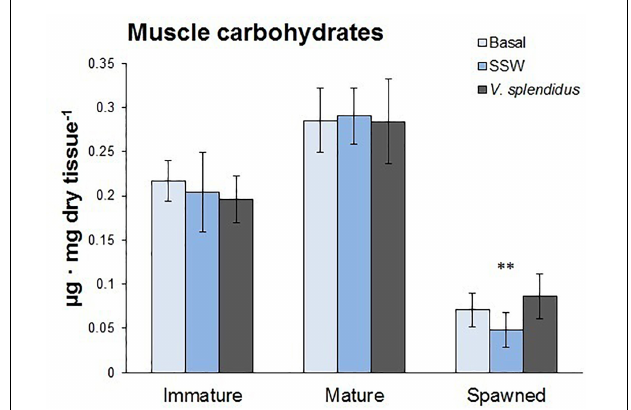
FIGURE 8 | Total carbohydrate content in the adductor muscle of immature, mature, and spawned A. purpuratus ( n = 4–8 per condition and treatment; ∗∗ P <